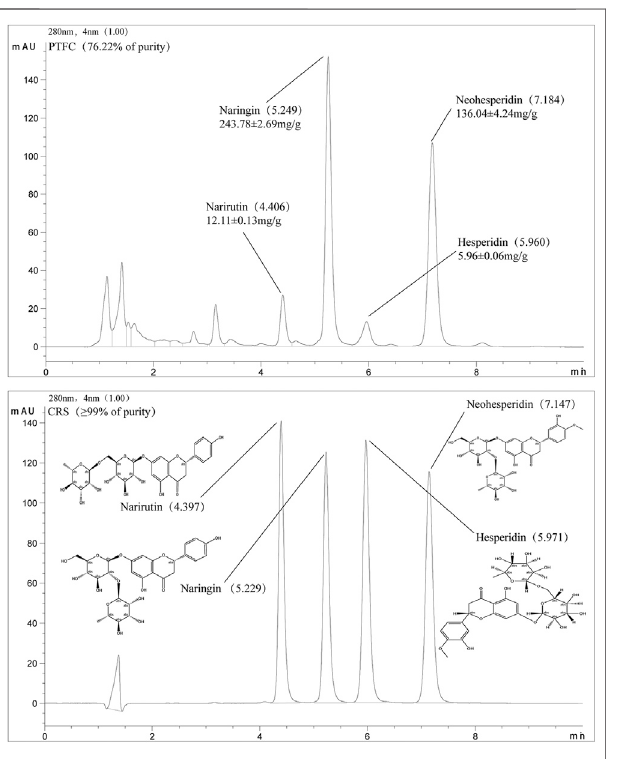
Frontiers in Pharmacology |